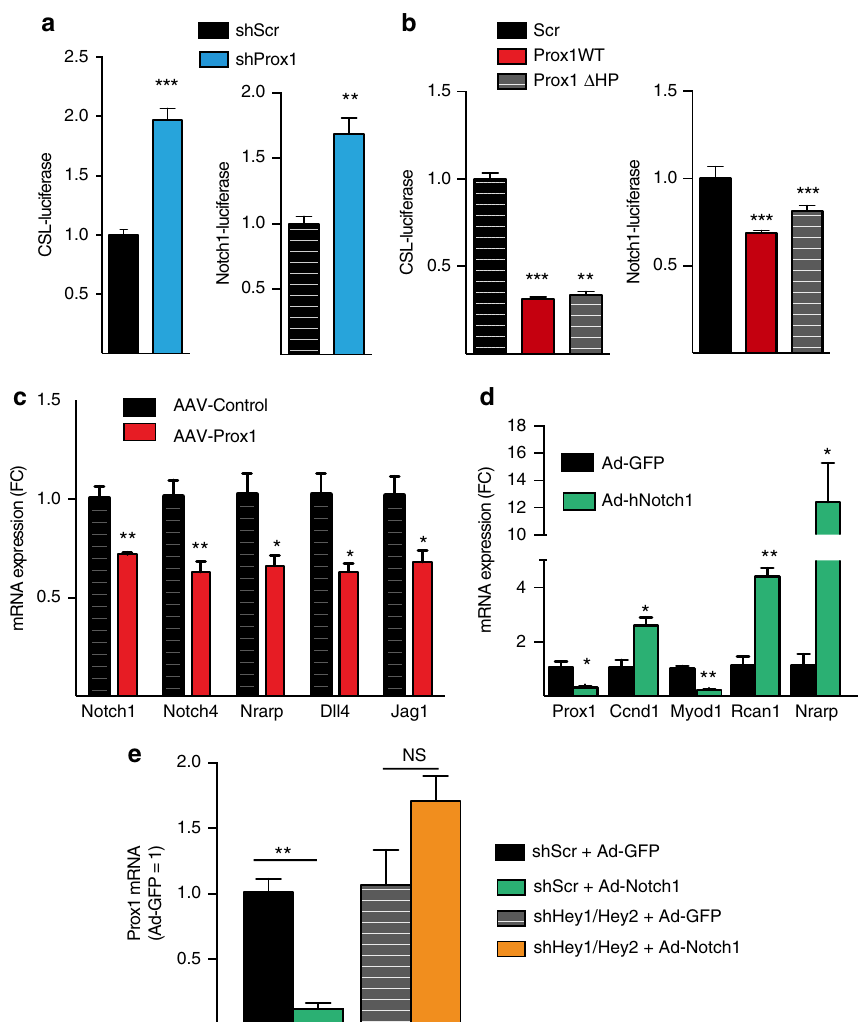
Figure 7 | Bidirectional regulation between Prox1 and Notch1 in myoblasts. ( a ) Notch luciferase activity in C2C12 cells transduced with lentiviral shScr or shProx1, and later transfected with CSL- or Notch1-luciferase reporter. ( b ) Effect of overexpression of WT Prox1 and the Prox1 mutant lacking the DNA-binding domain (Prox1 D HP) on CSL- and Notch1-luciferase activities. ( c ) Effect of Prox1 overexpression on Notch-related genes in vivo in TA muscle. ( d ) Effect of adenoviral Notch1 overexpression on Prox1, CyclinD1, MyoD and Rcan1 mRNAs in human primary myoblasts. Nrarp was used to indicate Notch pathway activation. ( e ) Effect of Hey1 and Hey2 silencing on Notch1-induced suppression of Prox1 expression in human myoblasts. Data is presented as mean ± s.e.m., n ¼ 4 þ 4 biological replicates in a and b and 3 þ 3 in d , e (all experiments were repeated two to three times), n ¼ 5 þ 5 in c . Student’s two-tailed unpaired t -test, * P o 0.05, ** P o 0.01, *** P o